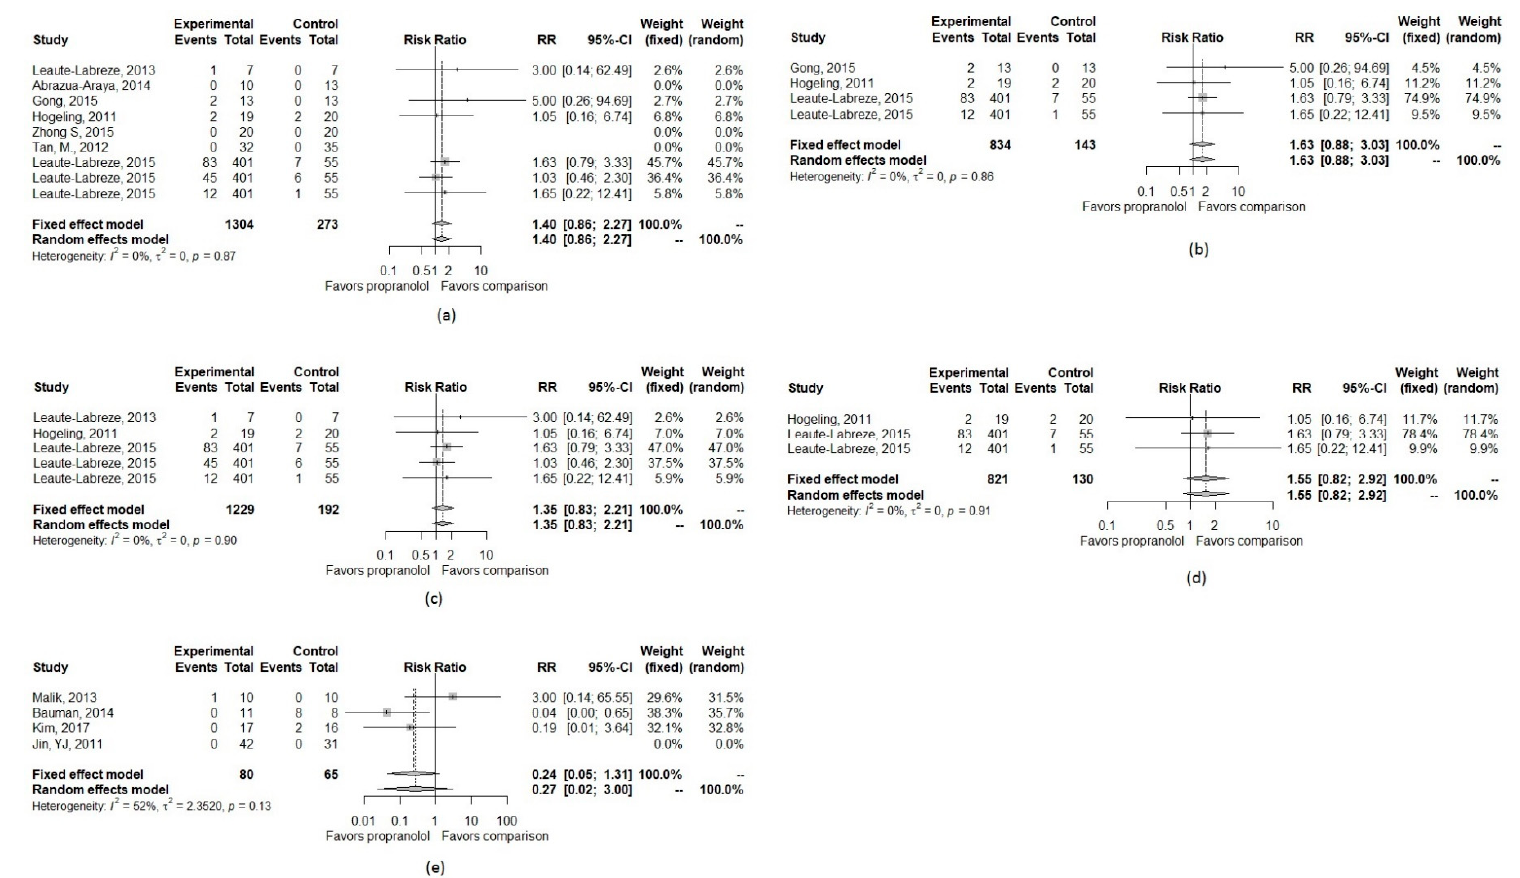
Figure A2. Forest plot of the pooled risk ratio of CNS and sleep-related effects in different comparison groups. ( a ) CNS effect with non-corticosteroids as the control group; ( b ) Sleep-related effect with non-corticosteroids as the control group; ( c ) CNS effect with placebo as the control group; ( d ) Sleep-related effect with placebo as the control group; ( e ) CNS effect with corticosteroids as the control group.